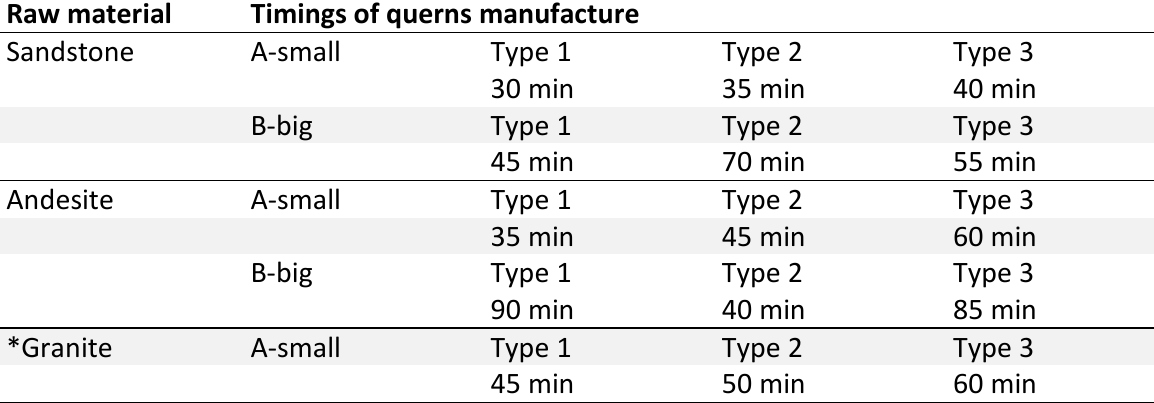
Table 3. Timings in the manufacture of experimental querns. Because of problems with raw material procurement, big granite querns were not manufactured in the